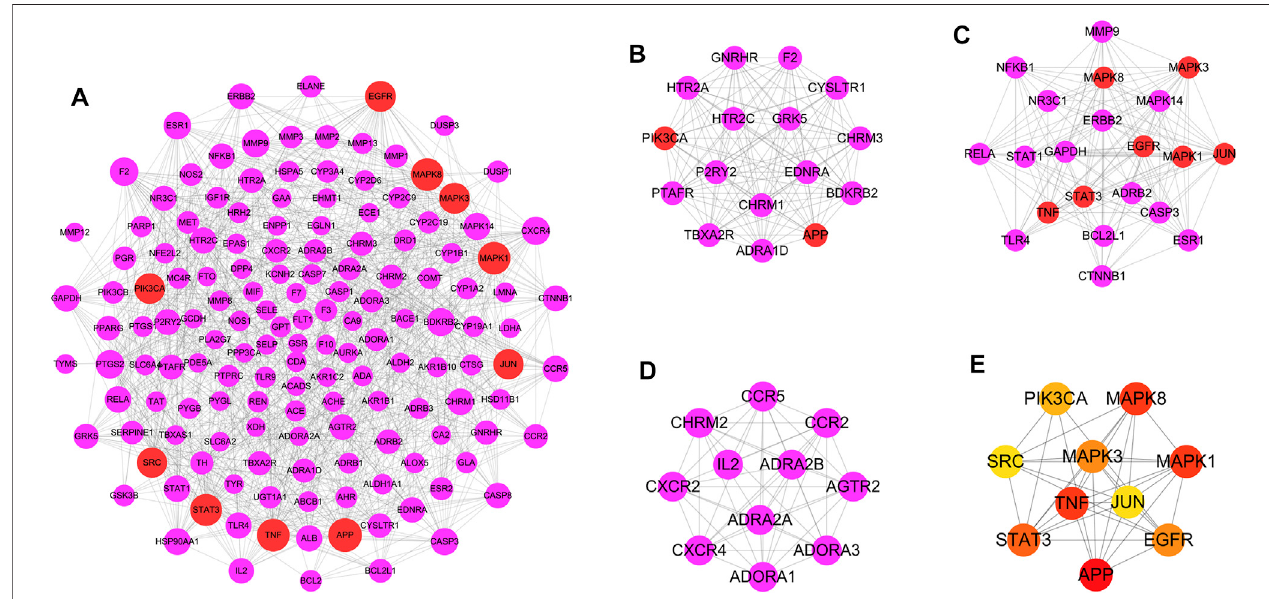
FIGURE 4 | Protein-protein interaction network and module analysis. (A) DHI-AMI target protein-protein interaction network. (B) Module 1. (C) Module 2. (D) Module3.Thepurple represents thecommontargetofDHIandAMI,and theredrepresentsthetop 10targets. (E) Theinterconnectiondiagramof10keytargets. From yellow to red, the darker the color, the higher the MCC